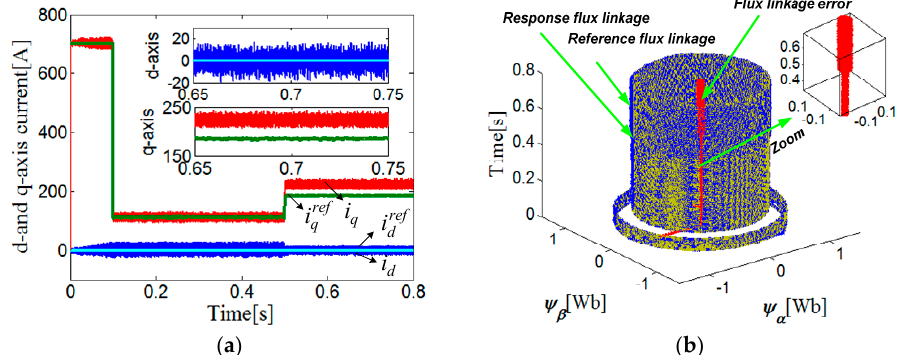
Figure 6. Simulation results of the conventional PCC method under flux linkage parameter perturbation. ( a ) d - and q -axis current responses and references; ( b ) three-dimensional rotor flux trajectories.